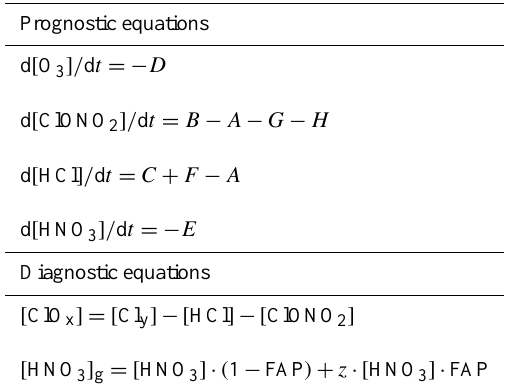
Table 1. List of equations used in SWIFT. Prognostic